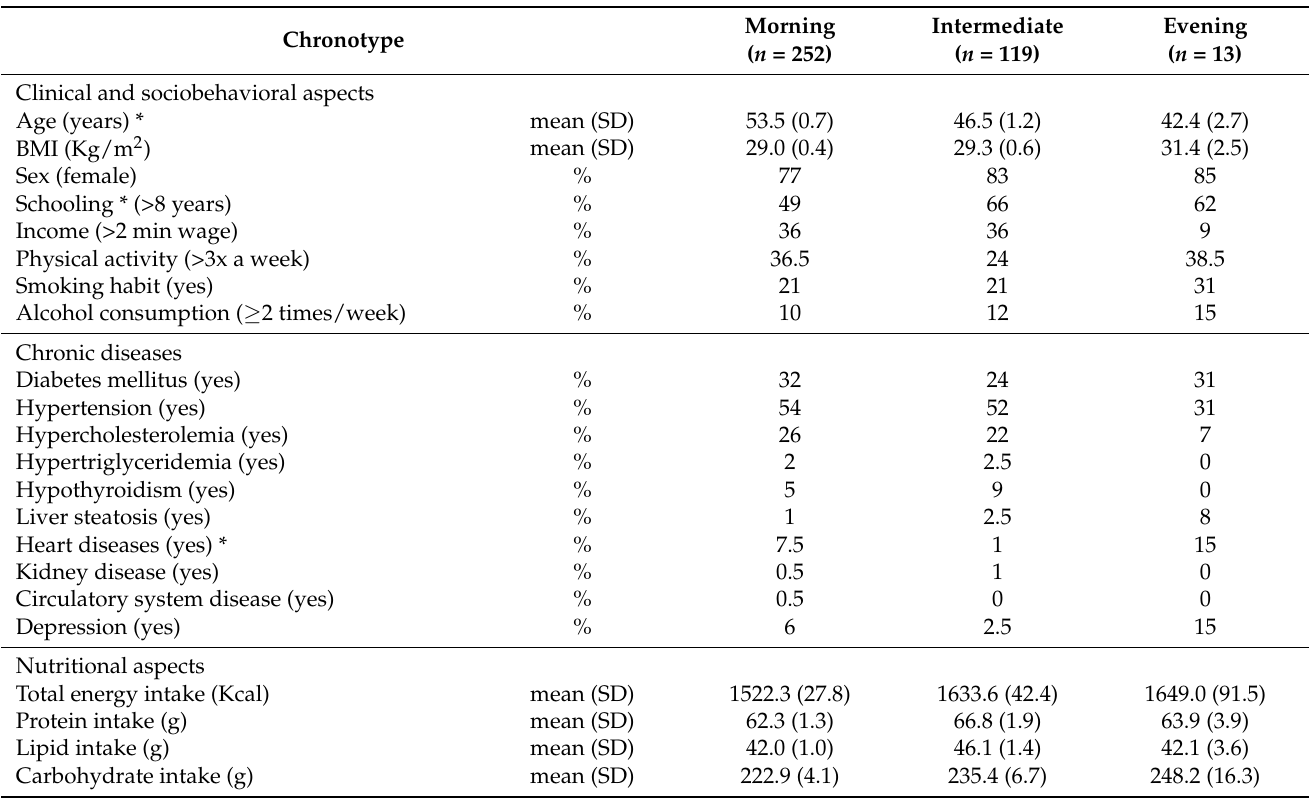
Table 1. Sociodemographic and clinical characteristics of the sample according to sex.